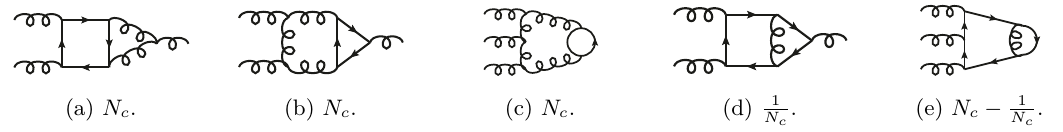
Figure 2 . The colour factor of each diagram in the gg → gγγ follows from the representative three-gluon, two-loop diagrams with a closed fermion loop shown